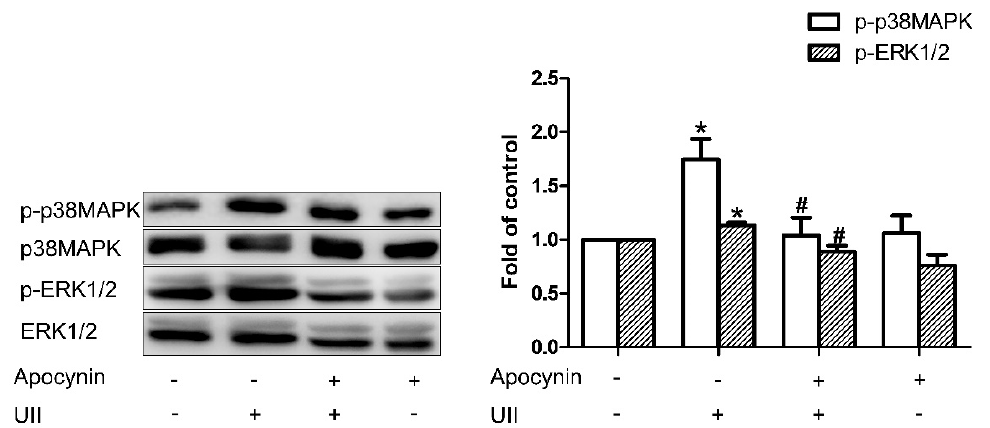
Figure 9. Representative Western blots analysis showing the relationship between ROS and MAPK in SH − SY5Y cells. The change in p − ERK1/2 and p − p38MAPK after pretreated with Apocynin. n = 6 in each group. * p < 0.05 vs. aCSF group; # p < 0.05 vs. aCSF + UII group.